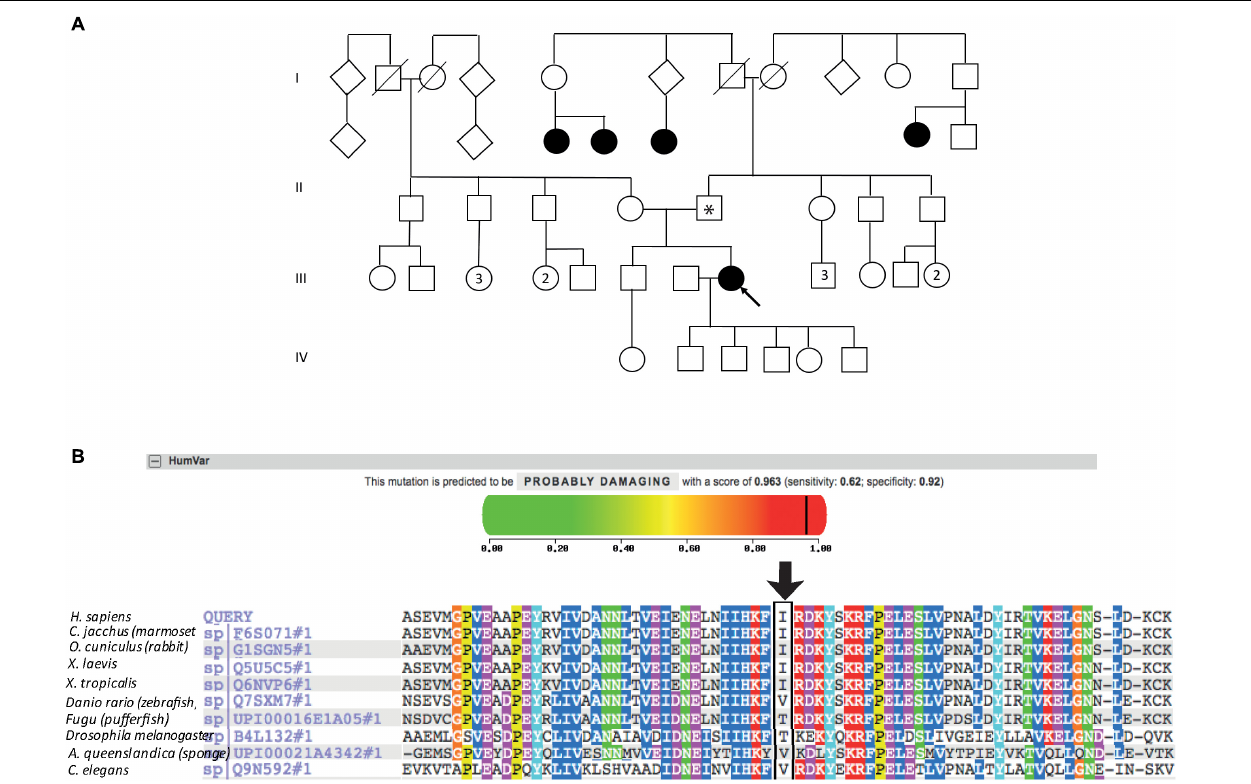
FIGURE 2 | Pedigree, PolyPhen2 and conservation analysis of PRPF31 c.341T > A Ile114Asn variant. (A) Family pedigree. Affected individuals in generation II had visual symptoms suggestive of retinitis pigmentosa and appear on both sides of the paternal grandparents of the proband. Arrow = proband. Asterisk = father of proband, also found to possess heterozygous PRPF31 c.341T > A Ile114Asn variant. (B) PolyPhen2 score predicts this variant is probably damaging with a score of 0.963 (top), alignment of PRPF31 sequence showing conservation of Ile114 and surrounding amino acids (bottom). Ile114 identity is conserved across tetrapods, from human to Xenopus tropicalis , and non-polar hydrophobic similarity is conserved from yeast to human, with variations in highly derived insects ( Drosophila melanogaster ) and fish ( Fugu ).